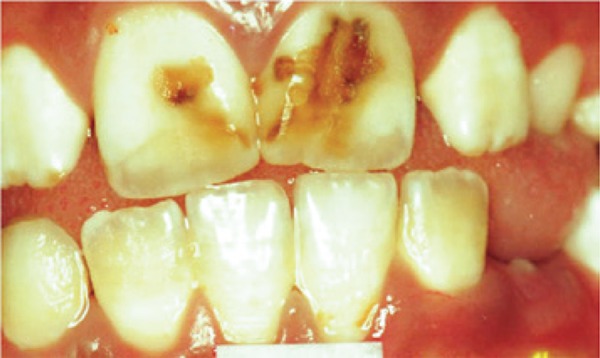
Dentes com fluorose severa